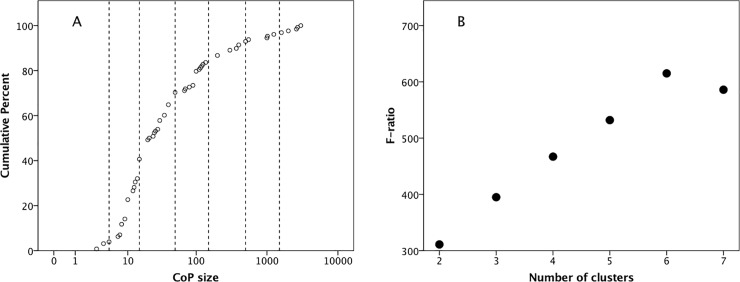
(a) Cumulative distribution of size of COPs. Vertical lines demarcate (L to R) 5, 15, 50, 150, 500 and 1500. Distinctive breaks in slope are evident in the vicinity of these lines. (b) Goodness of fit (indexed as F-ratio) for k-means cluster analysis of Community of Practice group sizes as a function of number of clusters.